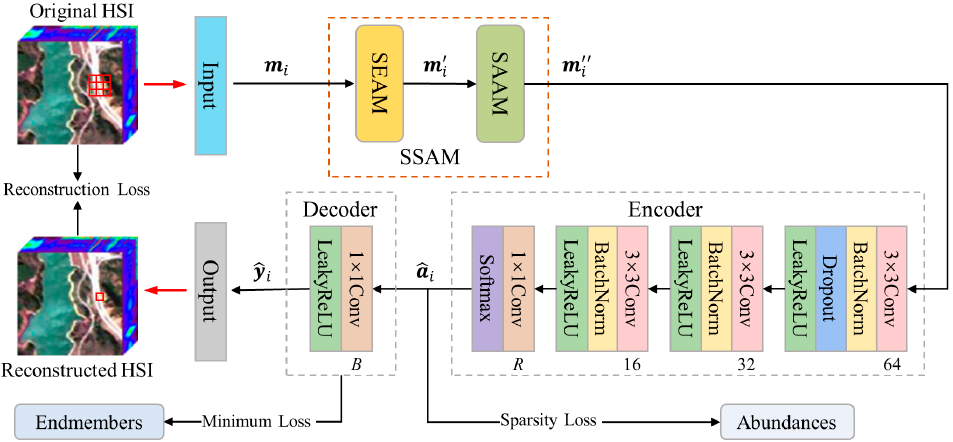
Figure 2. Network architecture of the proposed SSANet.